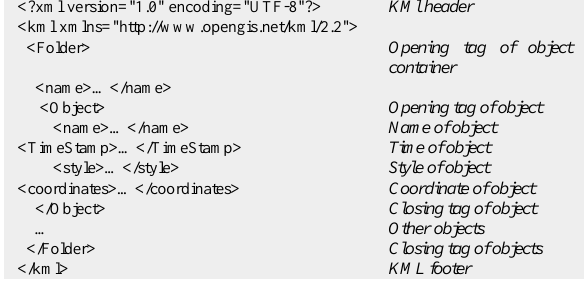
Figure 3. General structure of a KML file (Chien and Tan., 2011).